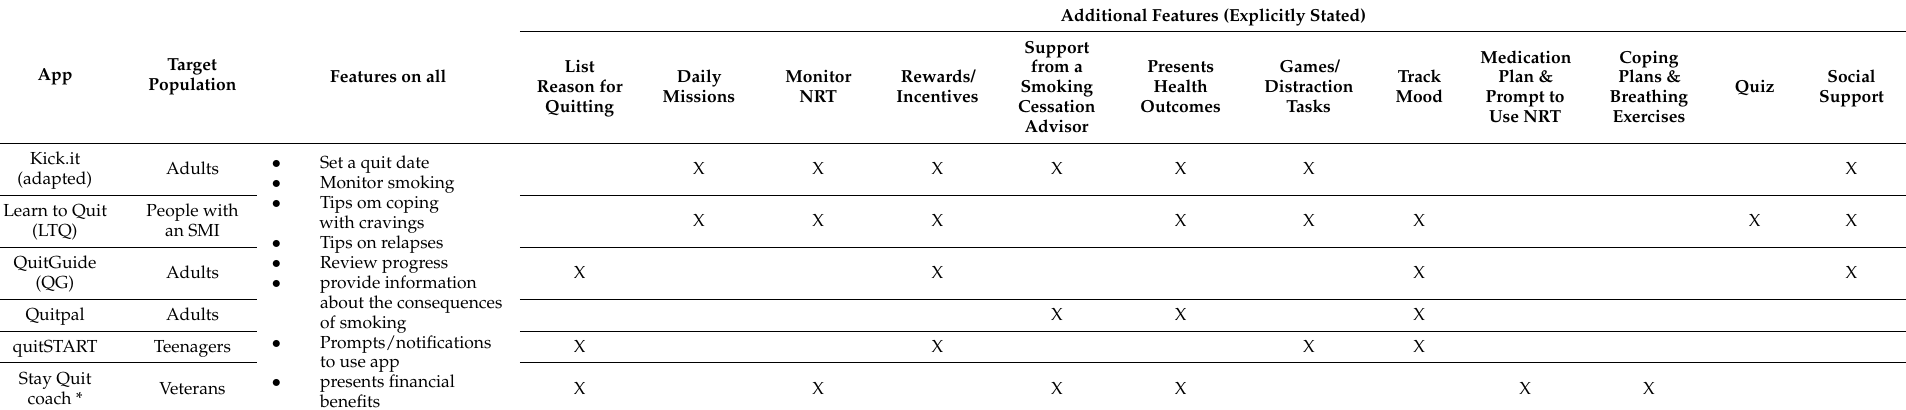
Table 2. Summary of the features of the apps.